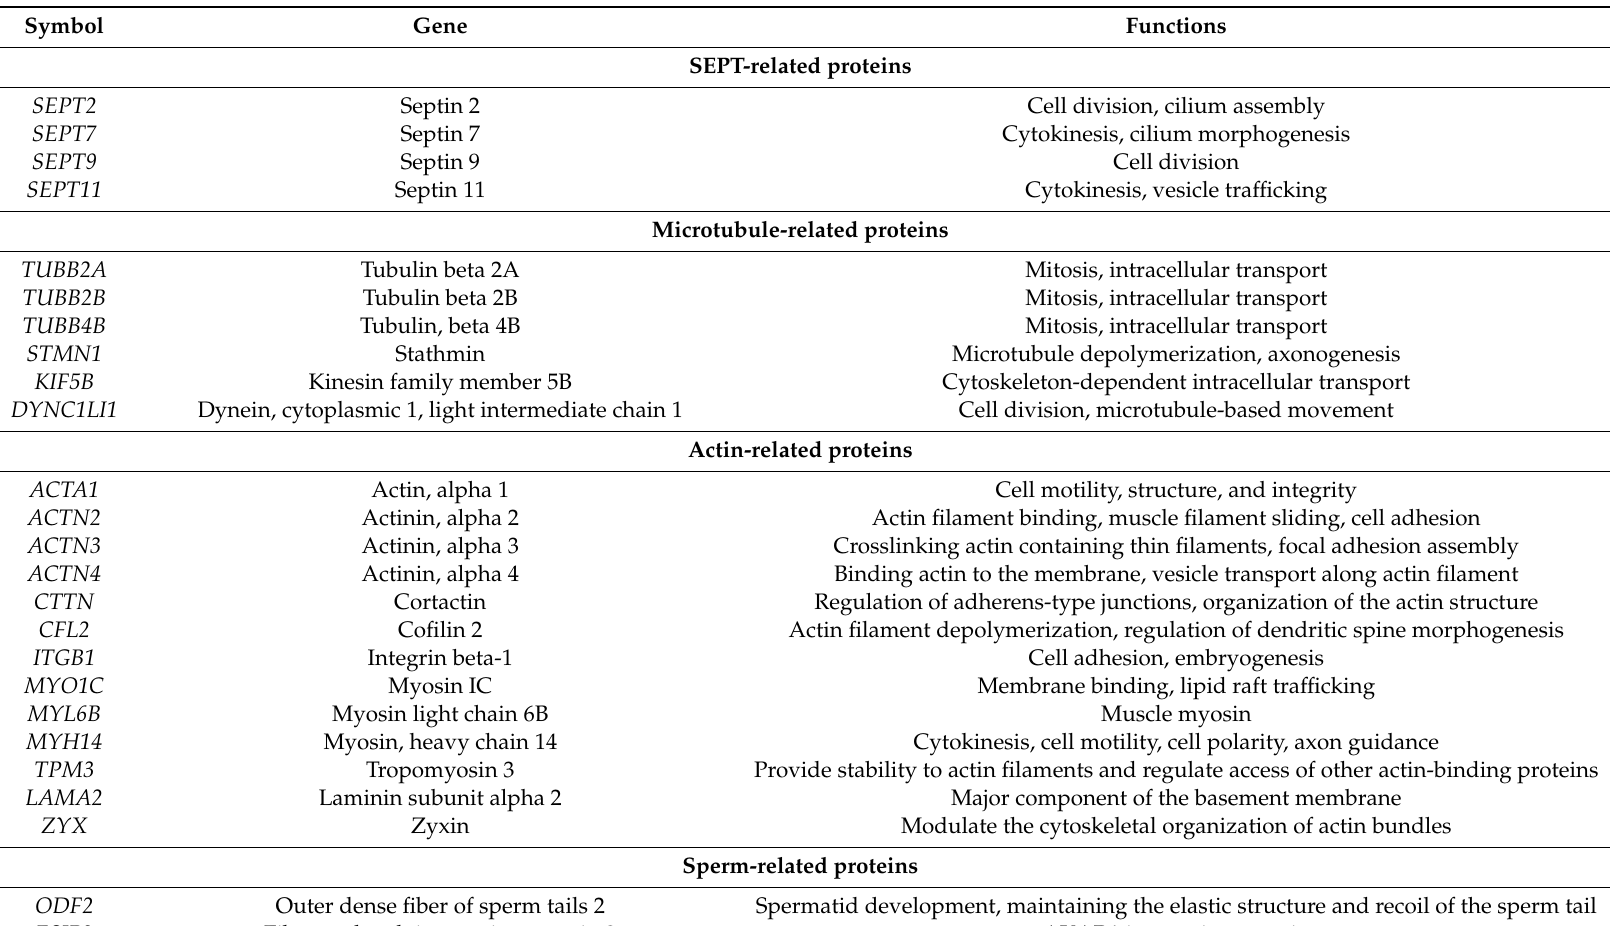
Table 1. SEPT14-interacting proteins identified by co-IP and nano-liquid chromatography-mass spectrometry / mass